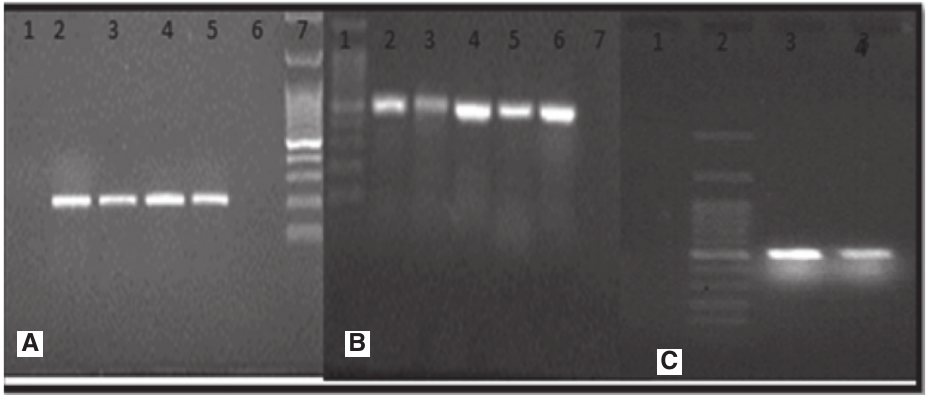
Figure 2: Gel electrophoresis of bla CTX-M, bla TEM, bla SHV PCR products. Lanes A7, B1, C2 contain a 100 bp DNA ladder, lanes A2 to A5 show PCR products for four samples which were positive for the blaSHV gene (231 bp), lane A6 was a negative control. Lanes B2 to B6 show PCR products for five samples which were positive for blaTEM (459 bp). Lanes C3 and C4 show PCR results for two samples which were positive for the blaCTX-M gene (560 bp).